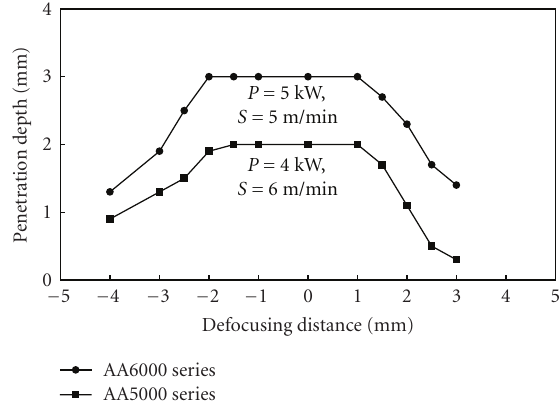
Figure 7: Penetration depth as a function of defocusing distance for the investigated aluminum alloys.